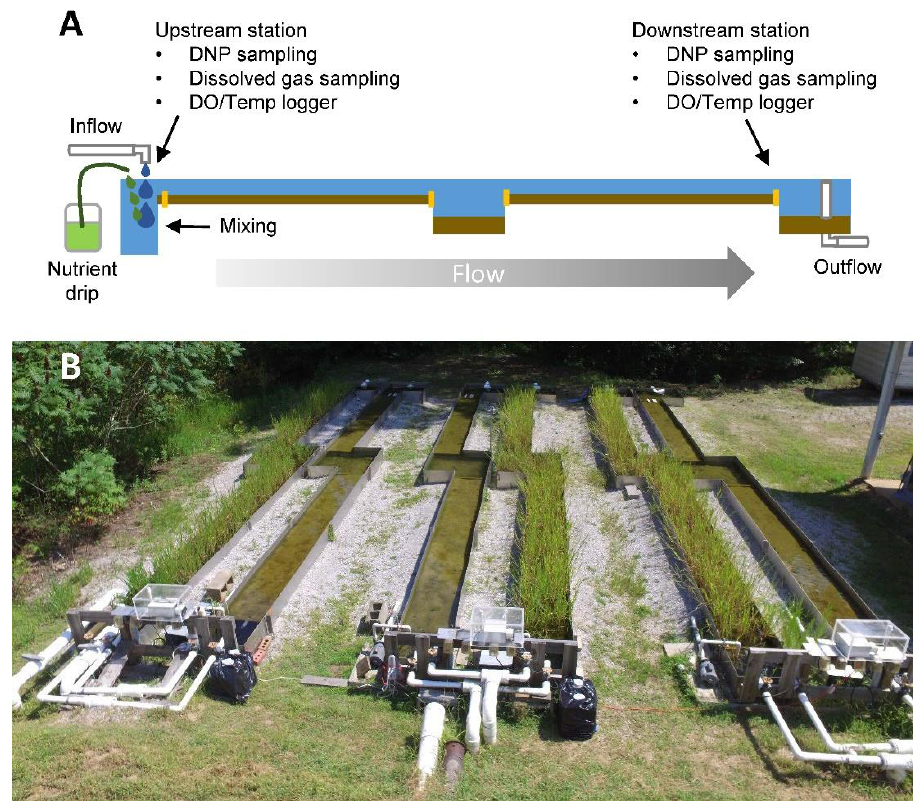
Figure 1. Schematic diagram of ( A ) experimental ditch setup depicting dosing and sampling method. ( B ) Picture of simulated drainage ditches at University of Mississippi Field station.